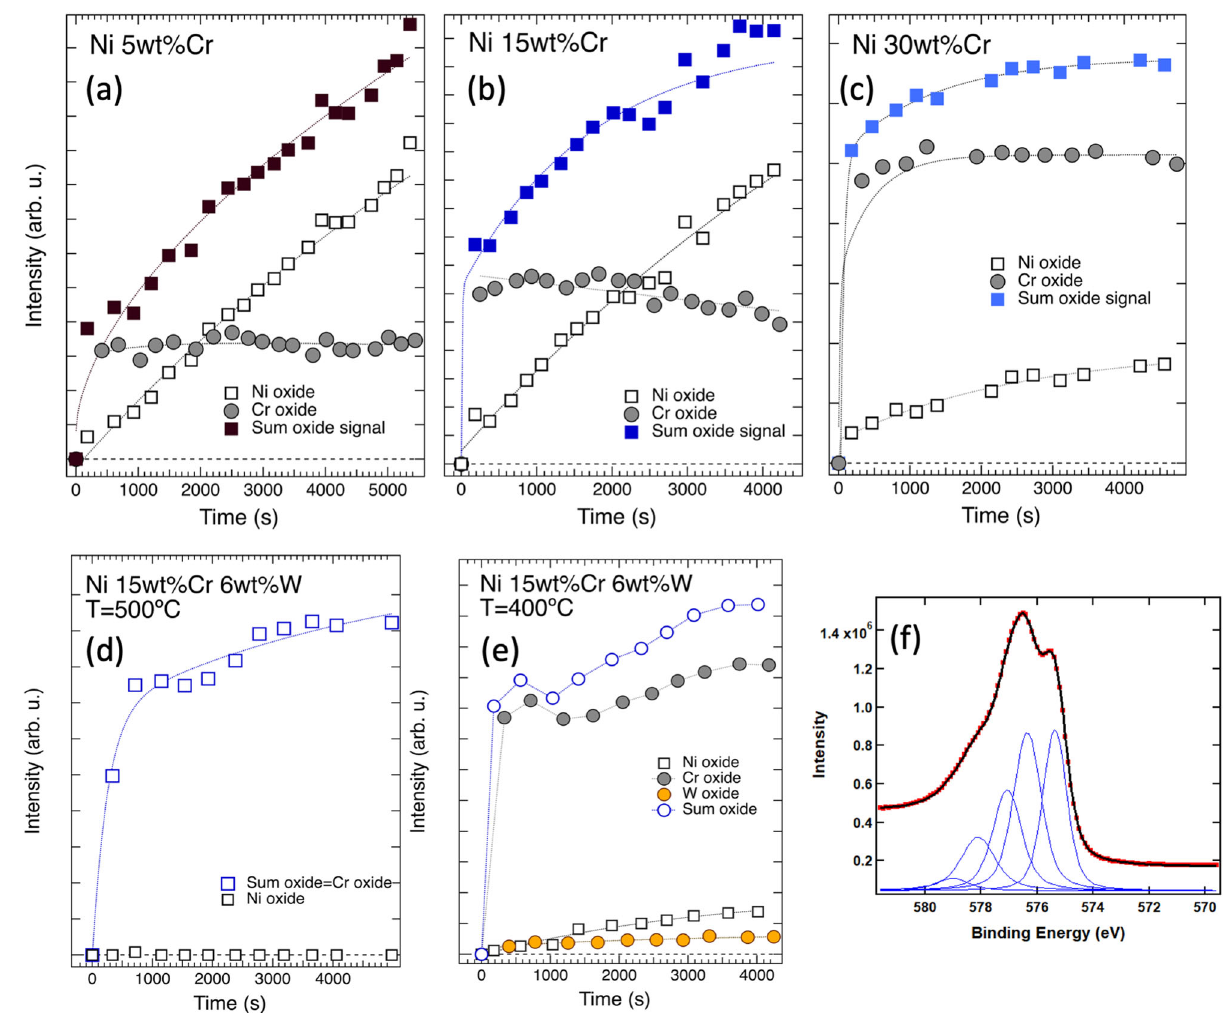
Fig. 5 Oxide composition. Chemically distinct contributions to the oxide signal for all alloys and both oxidation temperatures. The color coding of the sum over all oxide contributions follows the scheme set up in Fig. 4. a – c Binary alloys with Ni-oxide and Cr-oxide contributions. d , e Oxide composition of the ternary alloys, whereas oxidation at 500 °C only yields Cr-oxide. And ( f ) shows a fi t of the Cr 2p 3/2 core level observed in ( e ) after the fi rst few oxidation steps. The fi t uses the multiplet peaks as described by Payne et al. for a chromia reference